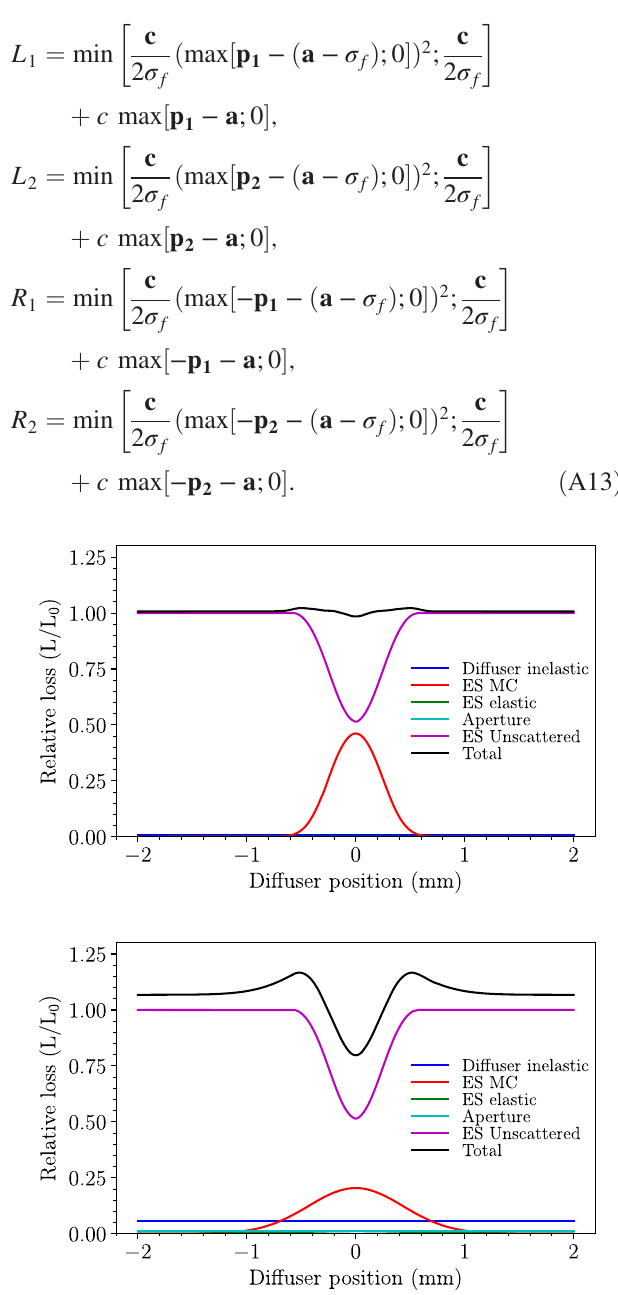
FIG. 20. Normalized phase-space representation at ES, after phase rotation through δμ x .